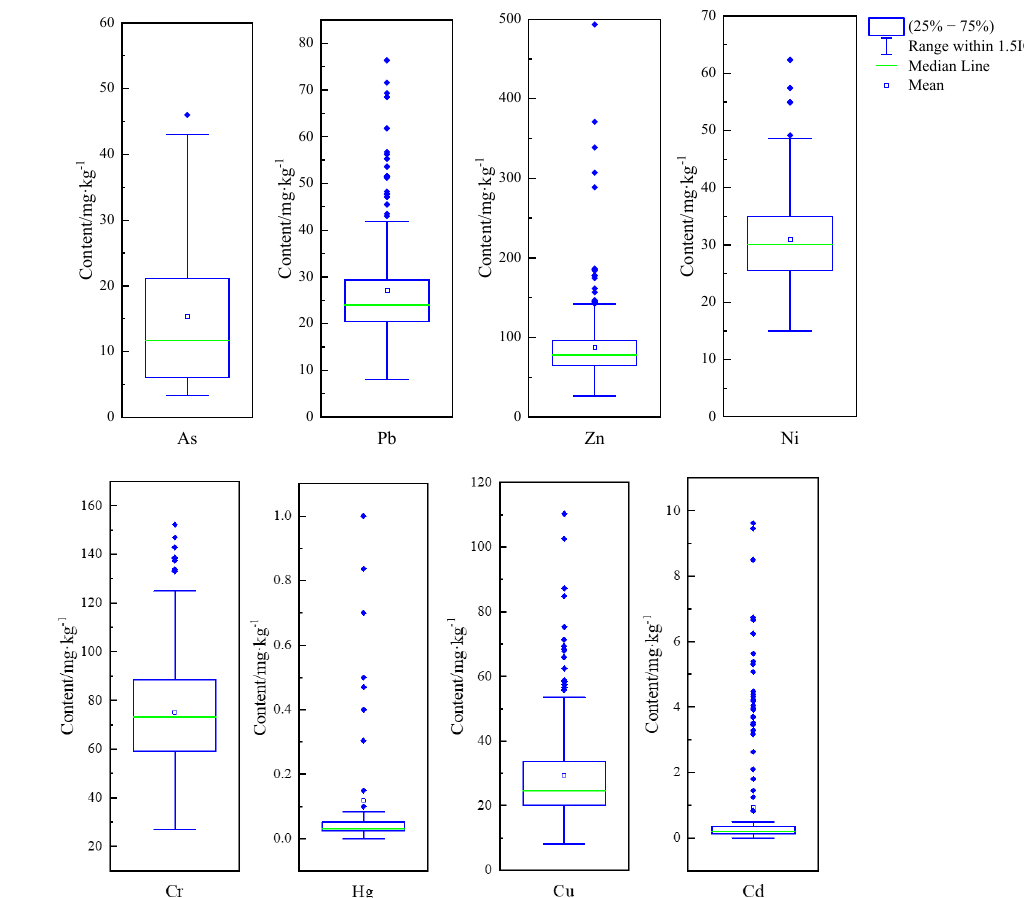
Figure 2. Statistics of heavy metal content in sediments of Weihe River Basin.